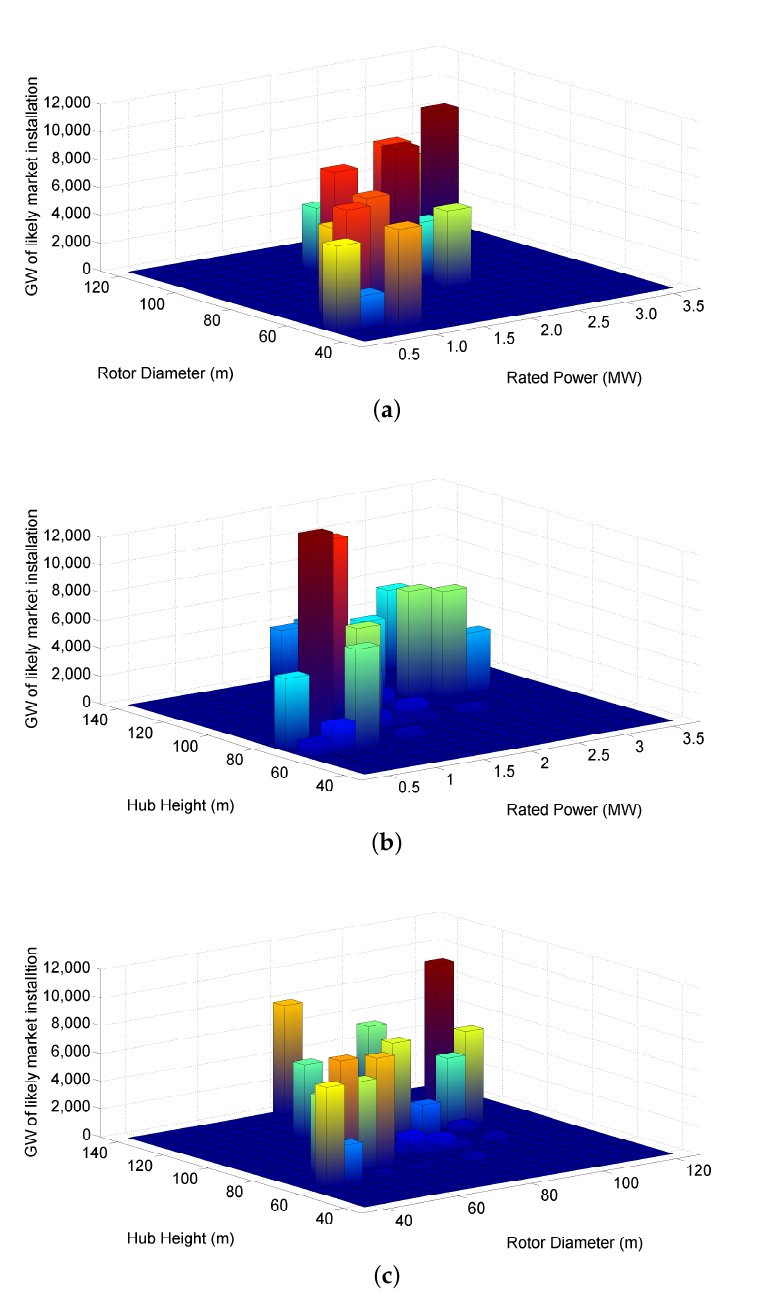
Figure 12. Performance-based expected market suitability (PEMS) of commercially available turbine feature combinations for the U.S. onshore wind market. ( a ) Rated power and rotor diameter combinations; ( b ) rated power and hub height combinations; ( c ) rotor diameter and hub height